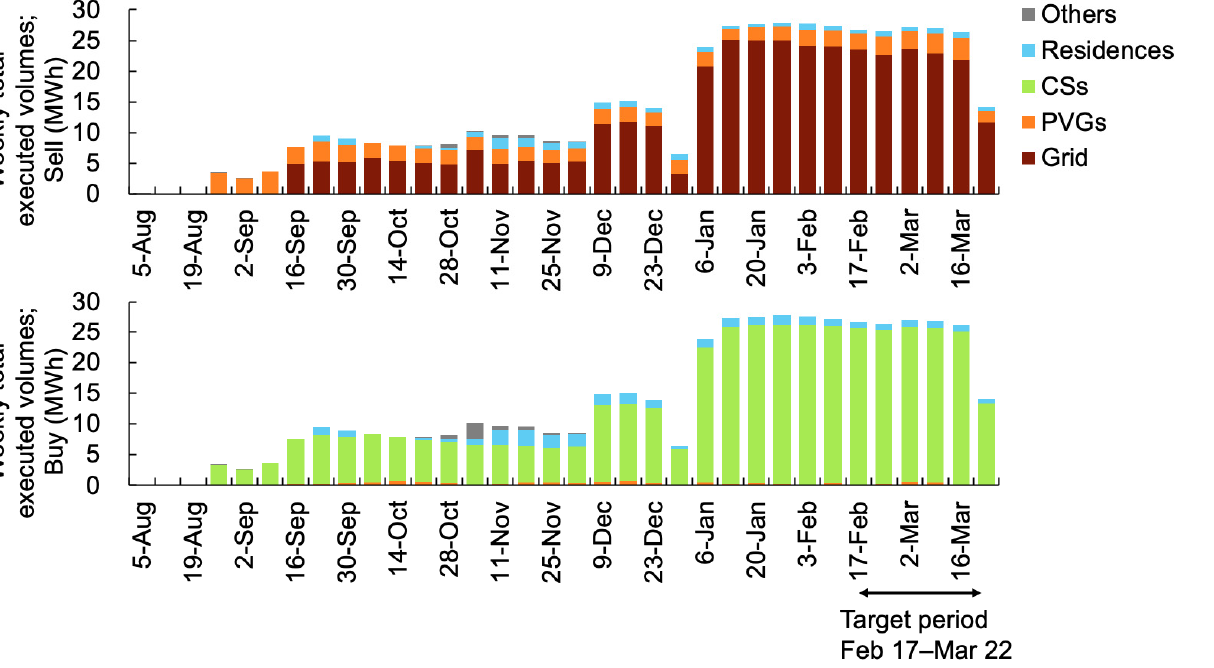
Figure 4. Selection from the target period for trade data analysis.